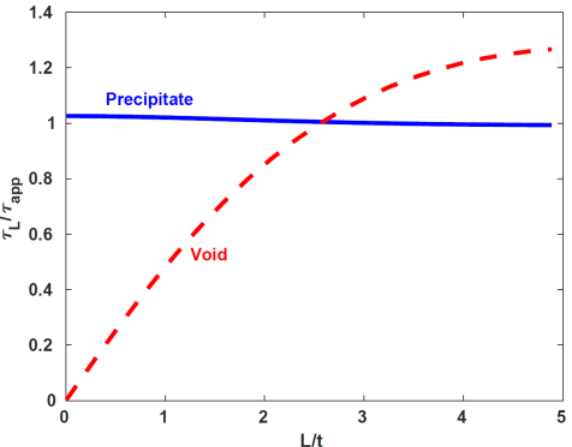
Figure 6. Stress distribution inside the matrix in the direction of the precipitate/void normal axis. Shear stress is normalized by externally applied stress τ app and distance L is normalized by precipi- tate/void thickness t .